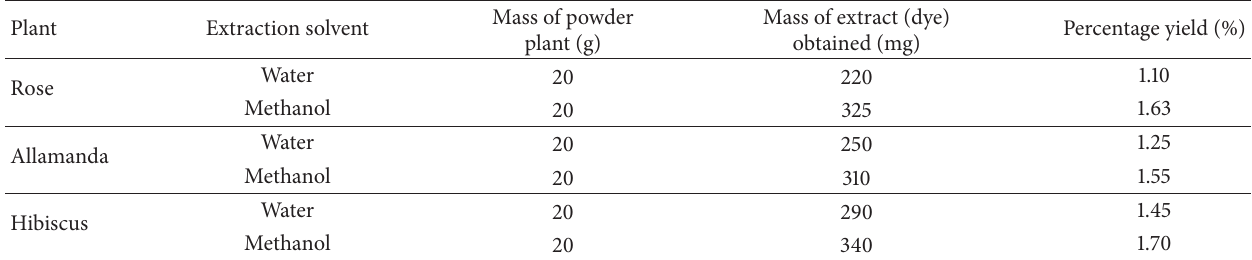
Table 1: Percentage yield of the plant extract.